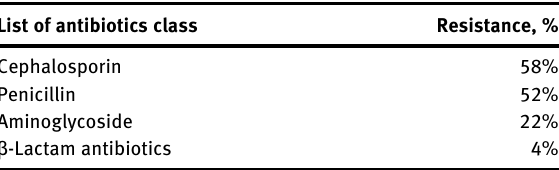
Table  : Resistance pro fi le of Gram-negative organism among study group population.